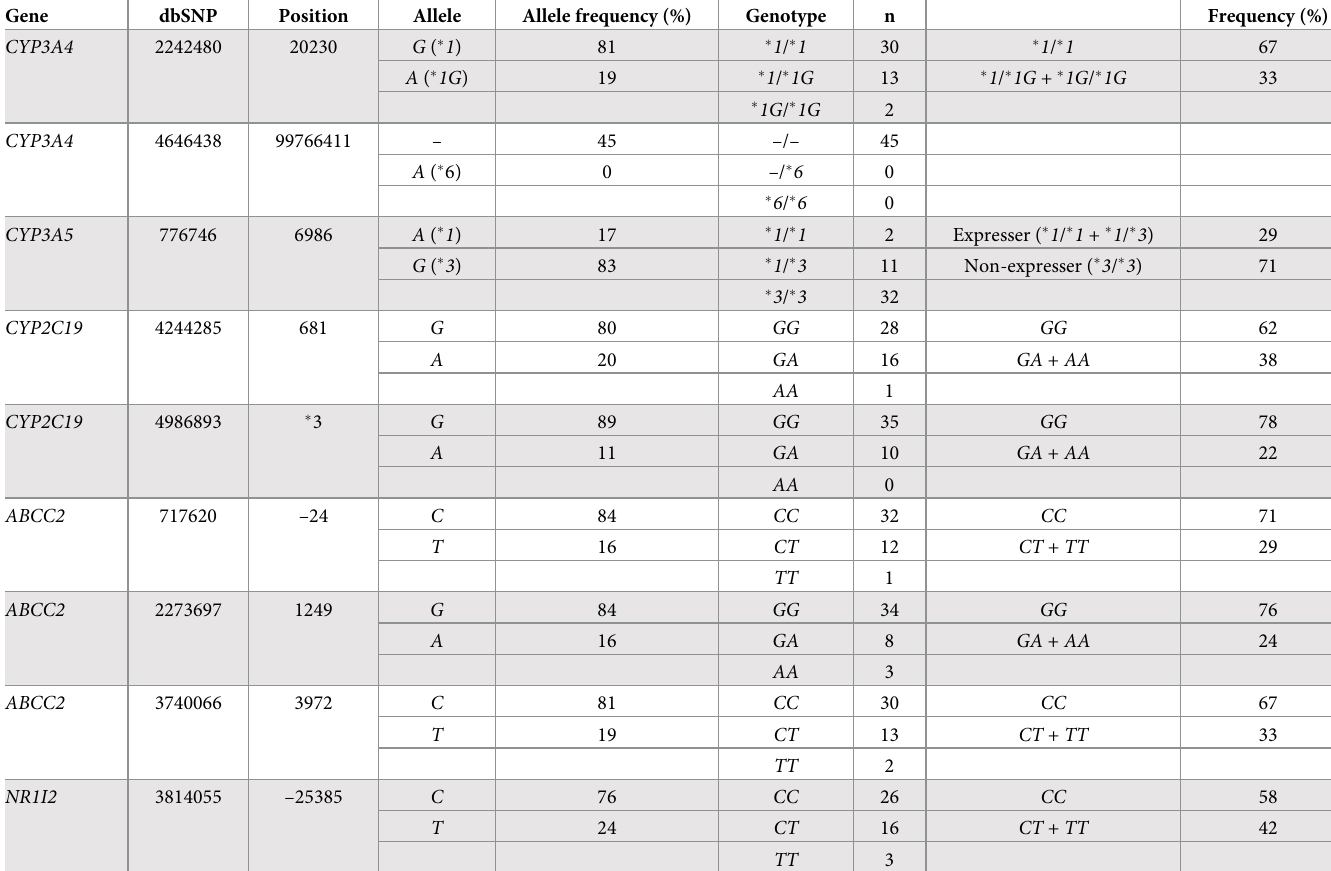
Table 2. Allele and genotype